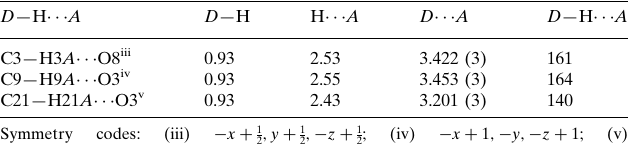
Hydrogen-bond geometry (A˚ , (cid:1)